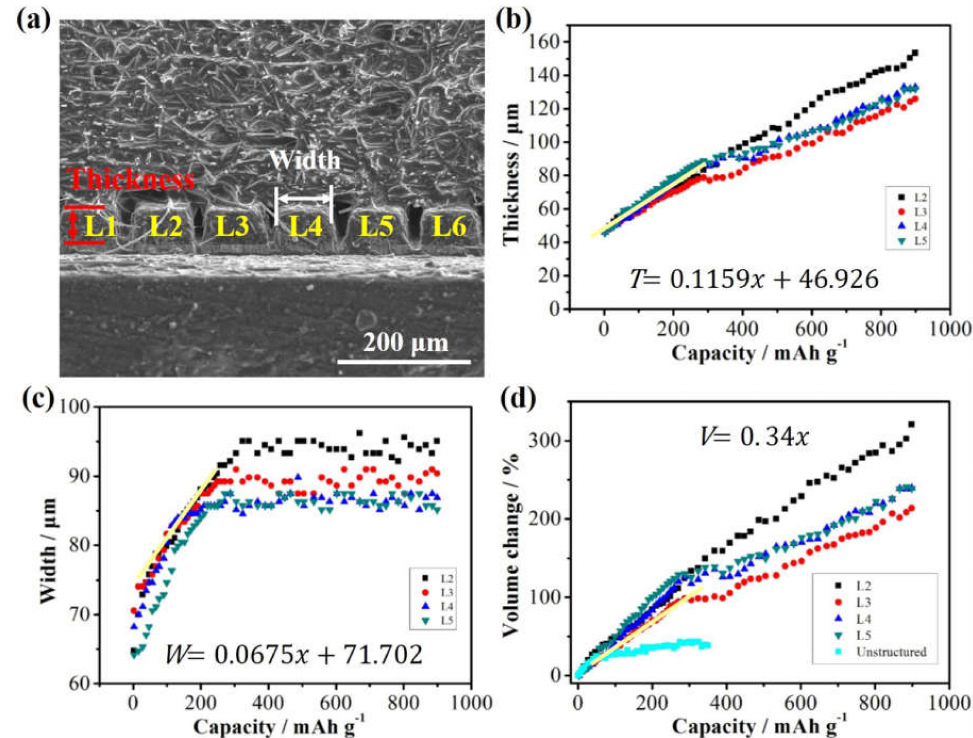
Figure 4. ( a ) The thickness and width of the selected sample were measured during the charging process. The ( b ) thickness and ( c ) width variations of 3D-line-structured Si/C composites during the charging process. ( d ) The volume change of 3D-line-structured Si/C composites during the charge process relating to the initial volume. (Measurement error: ± 1 µ